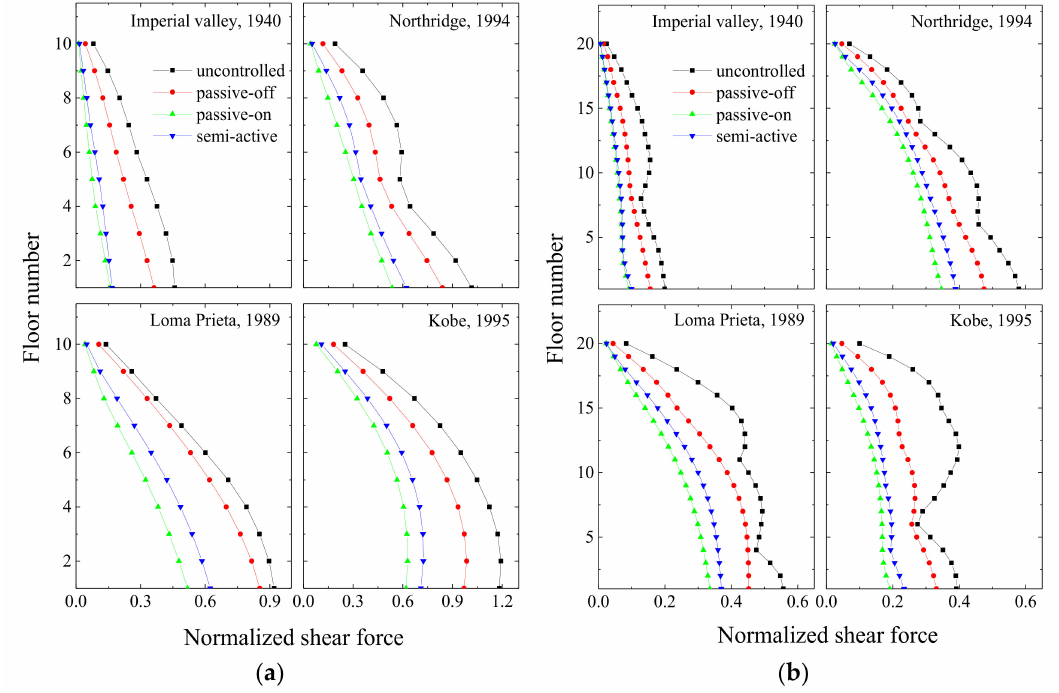
Figure 13. Peak floor shear under different control states in: ( a ) a coupled stiff building and ( b ) a coupled flexible building when MR dampers are used as coupling devices in Configuration